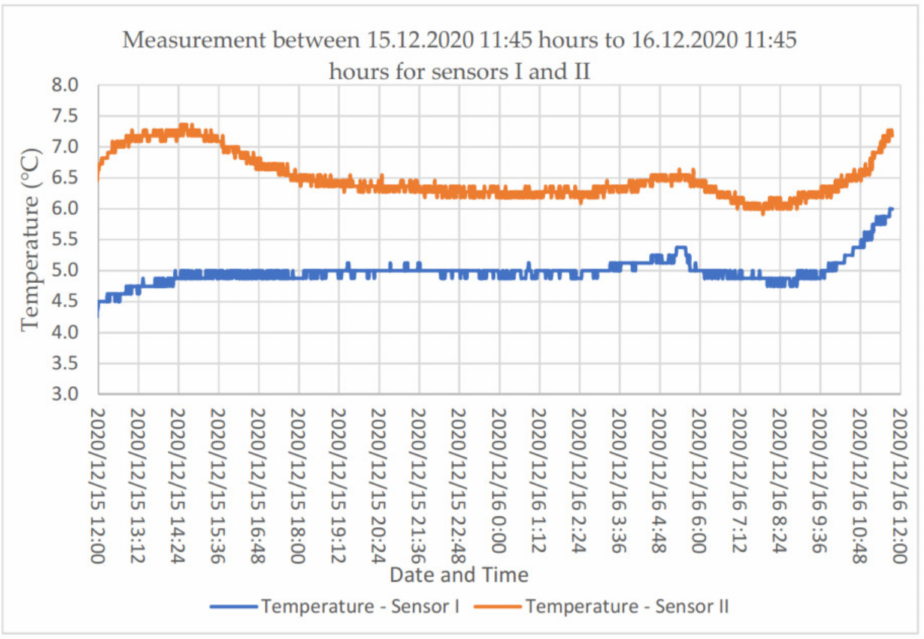
Figure 8. The 24-h temperature distribution for FBG sensors placed in the building